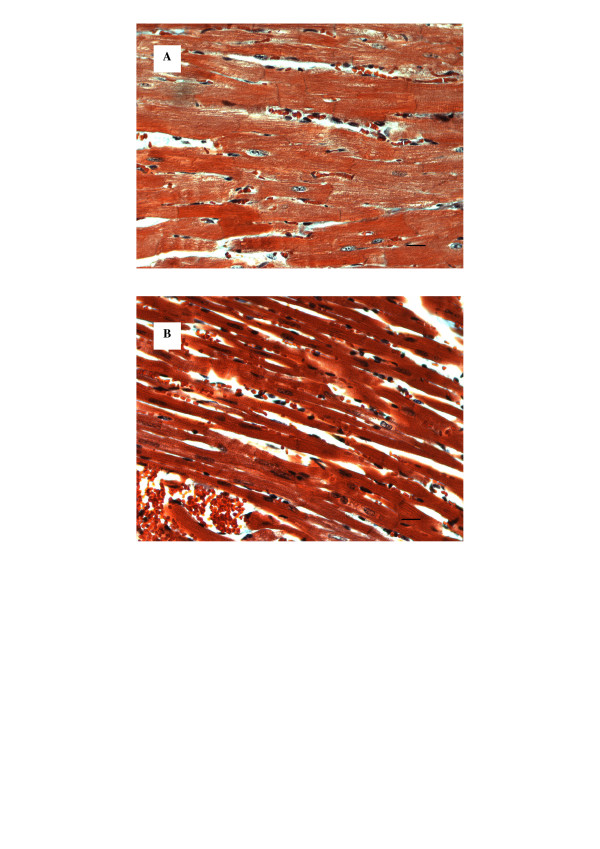
Histology of normal (a) and diabetic (b) myocardium (Heamatoxilin-eosin staining, 400×). The muscle fibers are thinner in the diabetic rats. Scale bar is 10 μm.